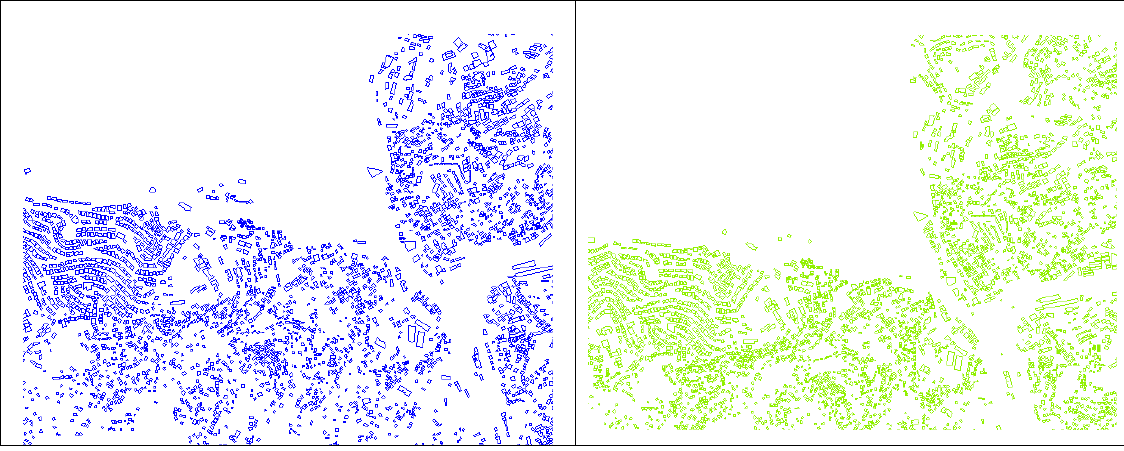
Figure 5. GIS Based analysis of on-screen manual digitizing results of the building from IKONOS-2002 image (left) and reference vector (right)